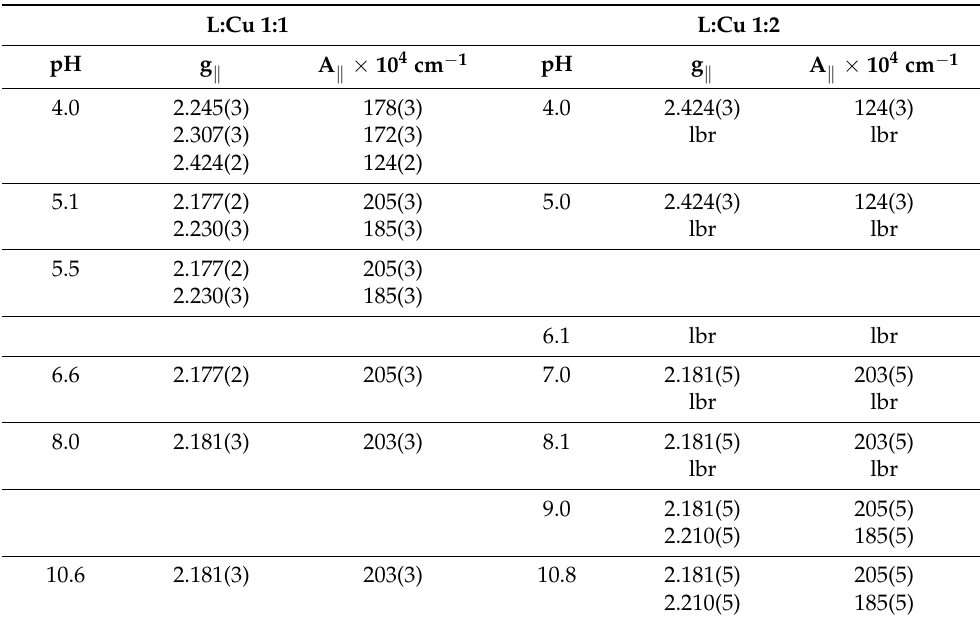
Table 5. ESR parallel Hamiltonian parameters of Cu 2+ with Ctr1 (1-14) at different metal-to-ligand ratios as a function of the